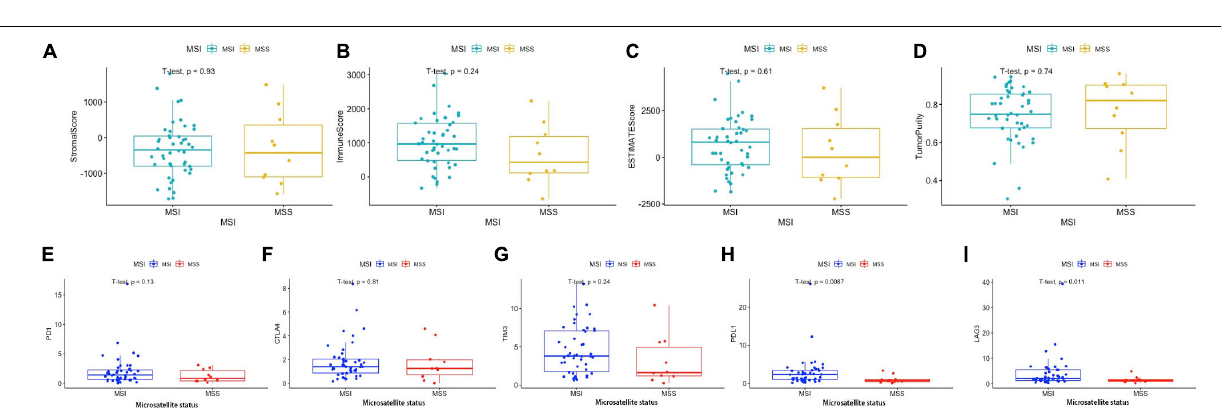
FIGURE 12 | Immune scores and immunotherapy-related genes according to MSI status. Stromal score (A) , immune score (B) , ESTIMATE score (C) , and tumor purity (D) in MSI and MSS groups. Expression levels of PD-1 (E) , CTLA-4 (F) , LAG-3 (G) , PD-L1 (H) , and TIM-3 (I) in the MSI and MSS groups. Student’s t -tests were used for all